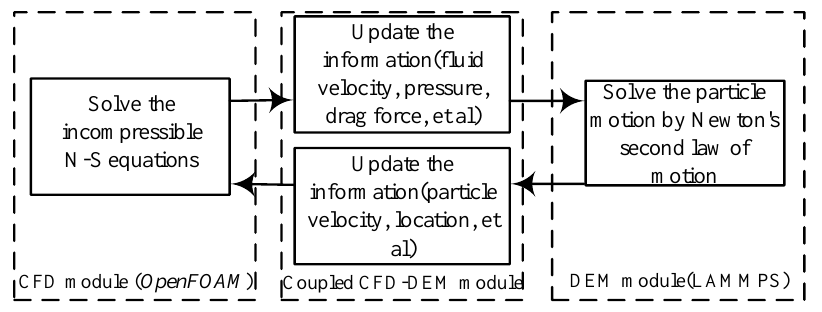
Figure 1. Flow path of SediFoam .